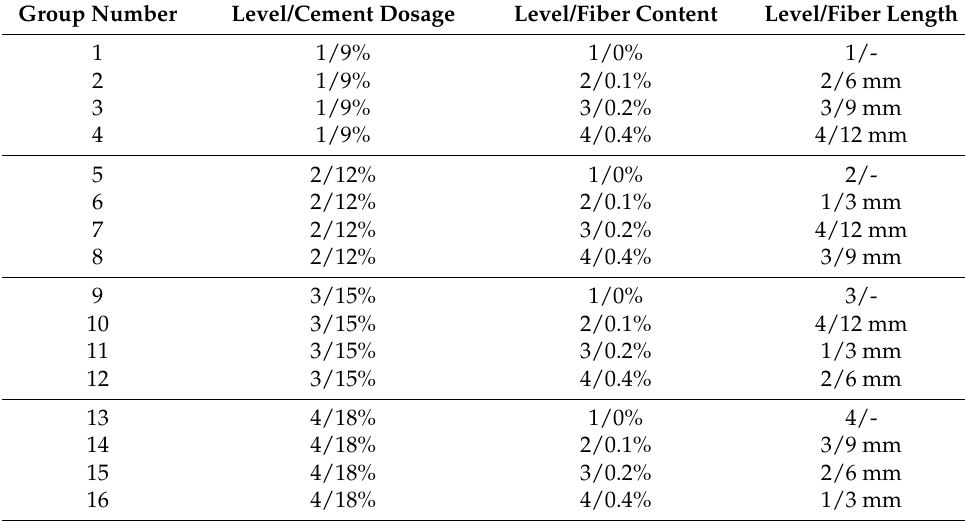
Table 4. Proportion of fiber solidified soil in each group.